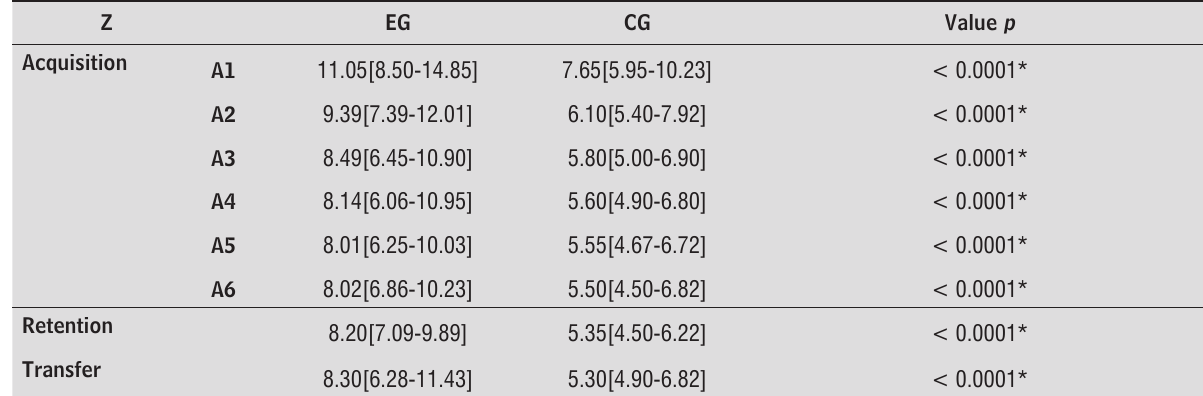
Table 1 - Comparison of variables (seconds) between groups. Data expressed in median and interquartile range (25-78 % ) Z EG CG Value